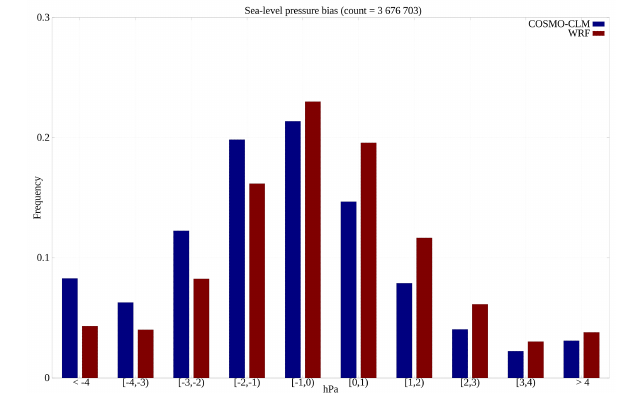
Figure 6. Bar graph showing the sea-level pressure error distribu- tions for the COSMO-CLM (in blue) and WRF (in red) models, derived through comparison with available hourly station observa- tions (3676703 in